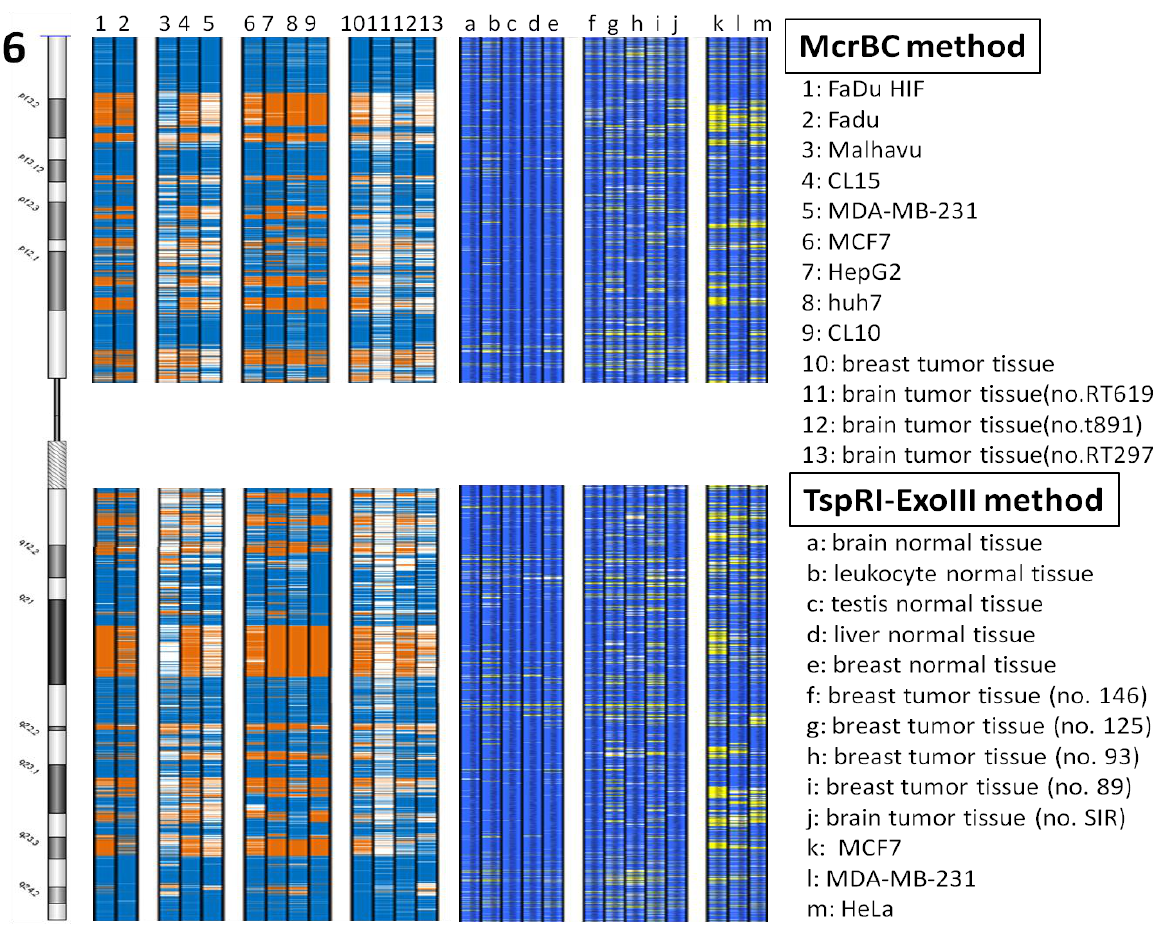
Figure 2. Domain-organization of CG methylation in tumor genomes using chromosome 16 as an example. Lanes 1-13, methylation pattern of tumor genomes analyzed by McrBC-array. The left figure represents chromosome 16, lanes 1-9 represents the methylation patterns of the tumor cell lines for this chromosome; lanes 10-13 represent primary tumors derived from the breast and brain. Lanes a-h, methylation pattern obtained by TspRI-ExoIII method. Lanes a-e are from adult brain, leukocytes, testis, liver and breast respectively. Lanes g-h represents the methylation pattern of MCF-7, MDA-MB-231 and HeLa, respectively. Yellow and orange represent the hypomethylation regions; while blue represent the hypermethylation